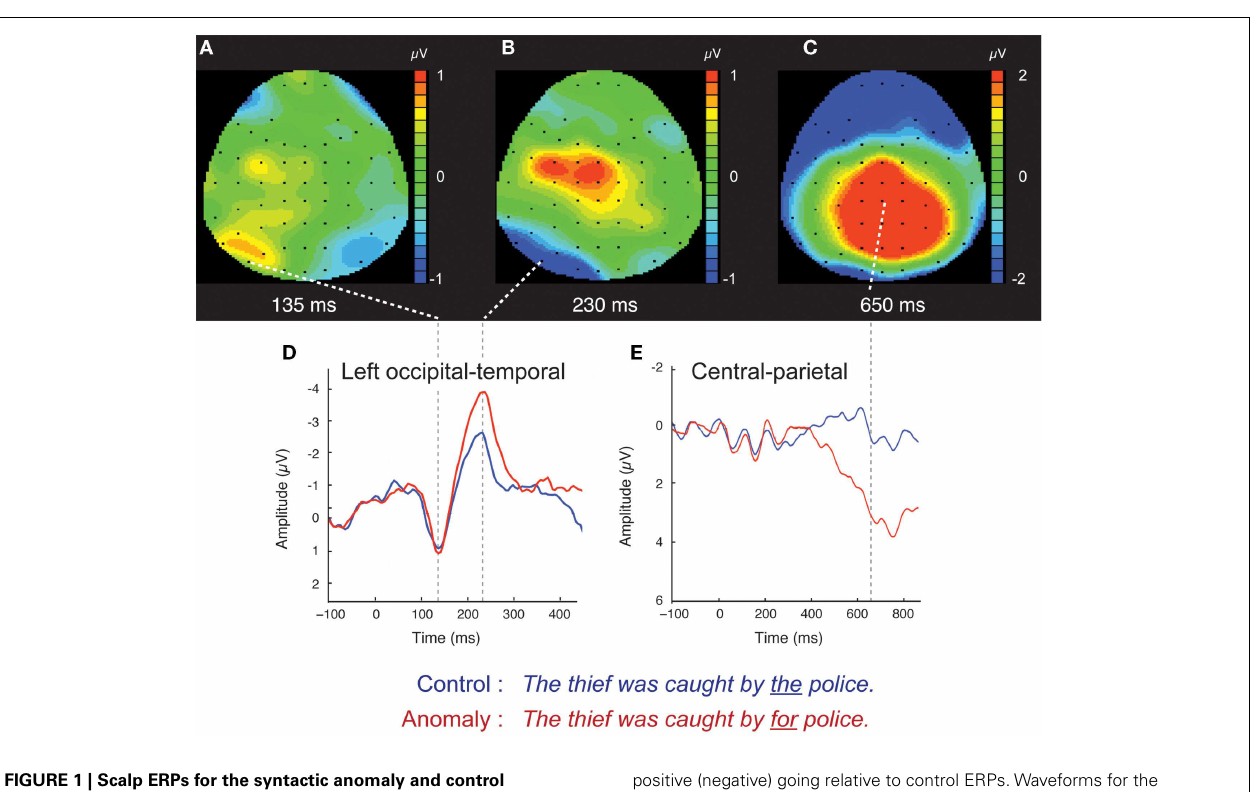
FIGURE 1 | Scalp ERPs for the syntactic anomaly and control conditions, collapsed across the distinction between high- and low-variability stimuli. Scalp distributions of the difference between anomaly and control are shown at three time points: 135ms (A) , 230ms (B) , and 650ms (C) . Red (blue) color indicates that anomaly ERPs are